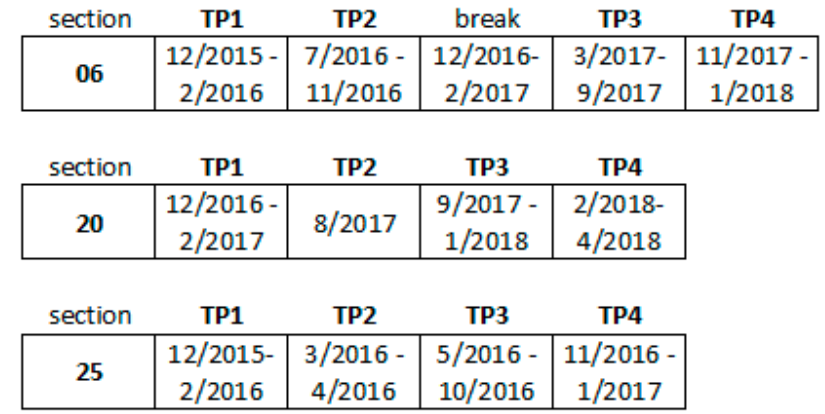
Figure 2. Summary of defined time periods.